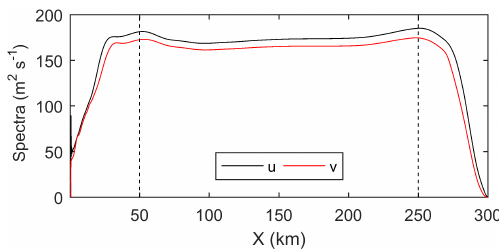
Figure 11. Spatial variation of depth-mean near-inertial spectra of velocities for the stratified case.